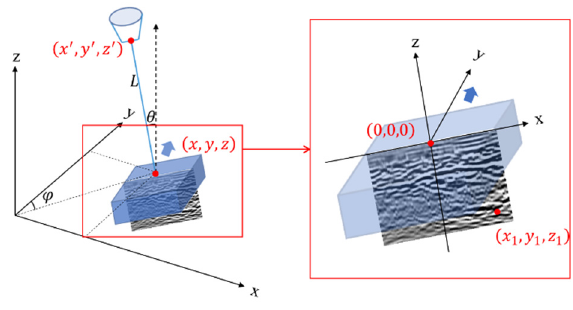
Figure 3. The position state of 3D GPR equipment Firstly, the GNSS coordinates need to be tilt corrected to calculate the corresponding WGS84 coordinates for the sampled point data. The Equation (4) of tilt correction is shown as follows, pitch and yaw can be derived from the inertial guidance measurement unit.